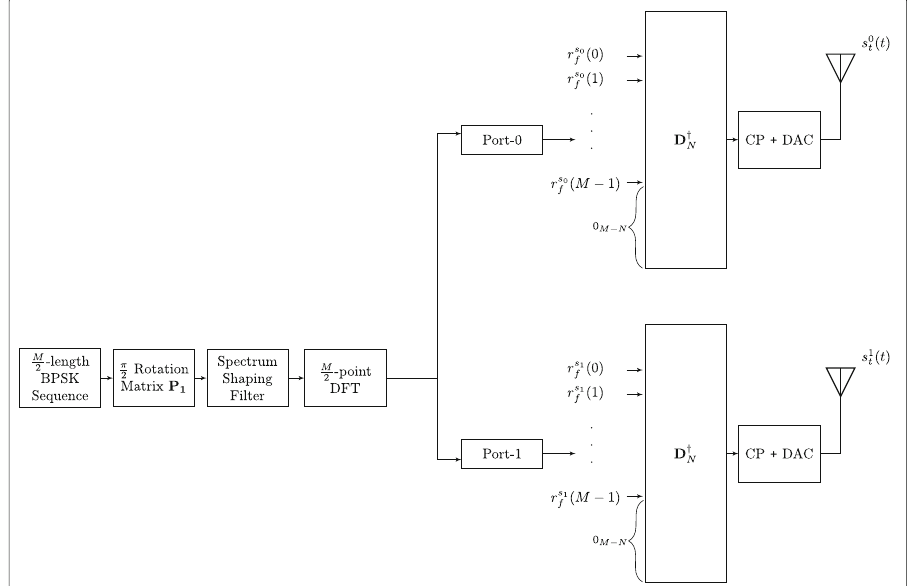
Fig. 11 Transmitter architecture for DMRS waveform generation for port -0 and port -1 using method